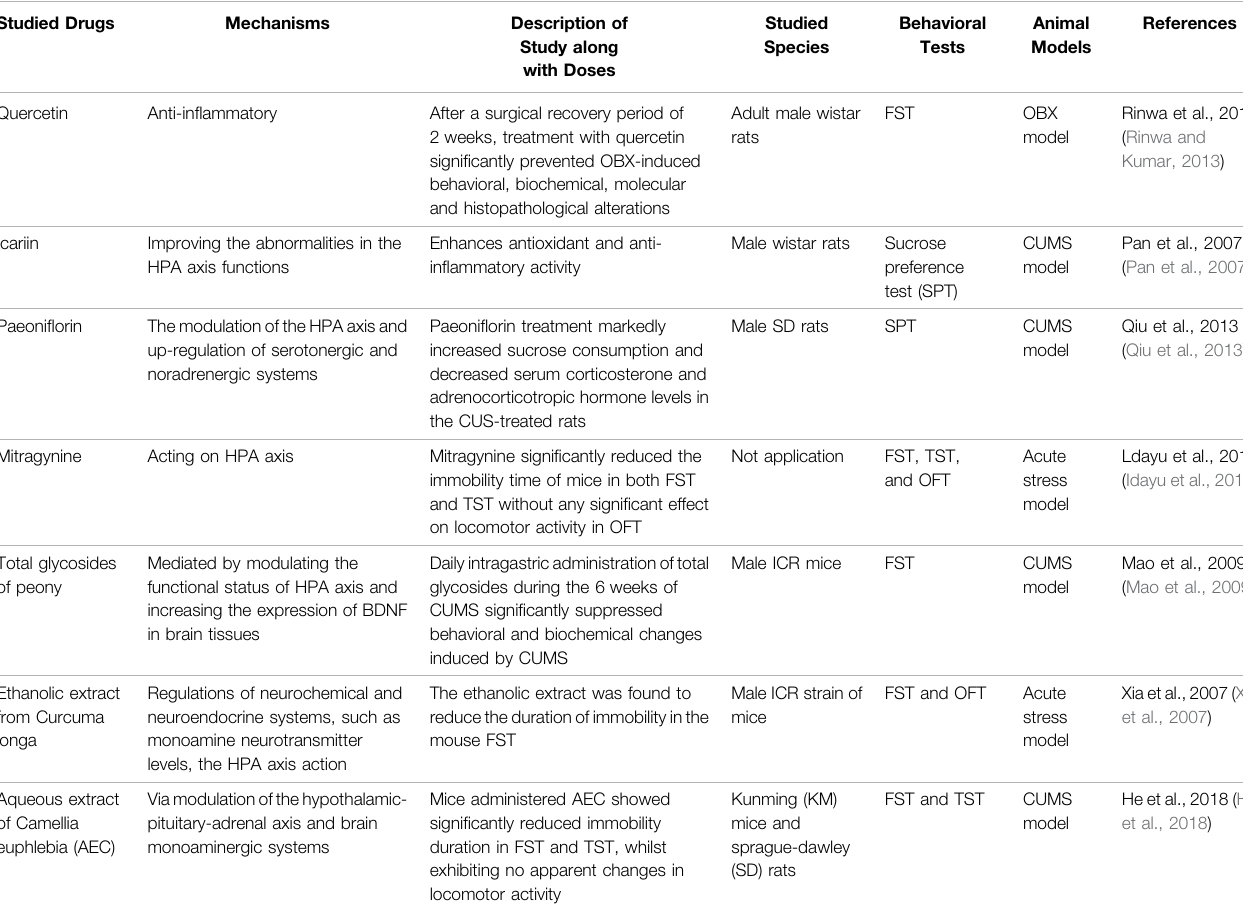
TABLE 2 | Potential natural products for the treatment of PSD by anti-in fl ammation and modulating HPA